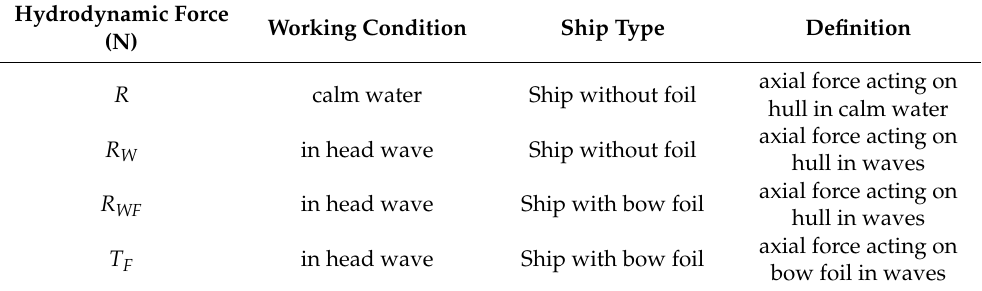
Figure 15. Thrust enhancement ratio ( 𝑟 𝑇𝐸 ) of bow foil at different speeds and different spring stiff- ness.